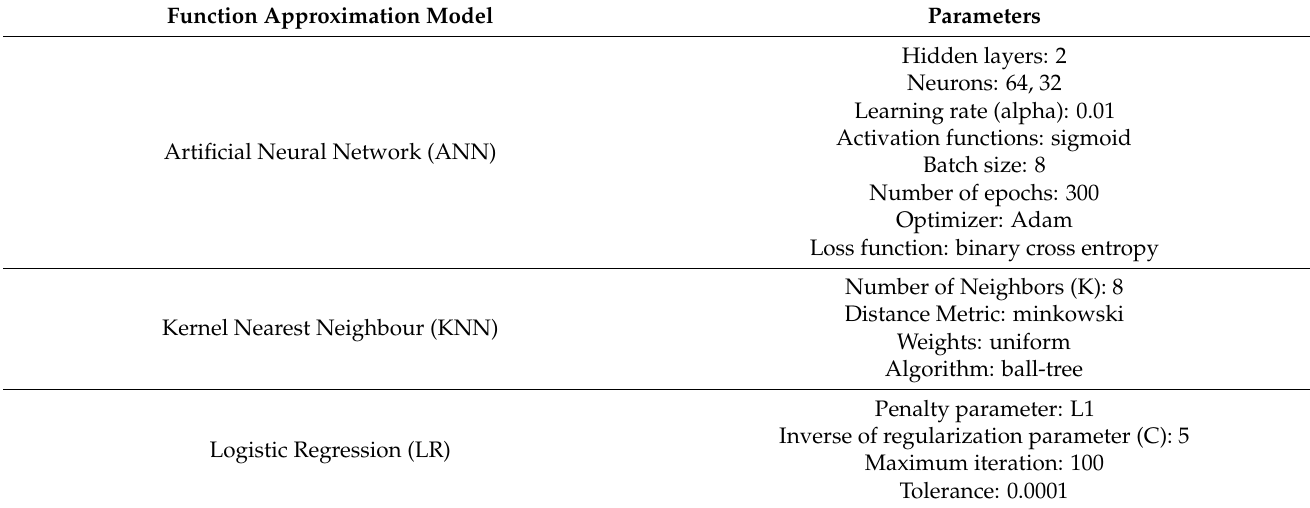
Table 4. Training parameters of function approximation-based classification